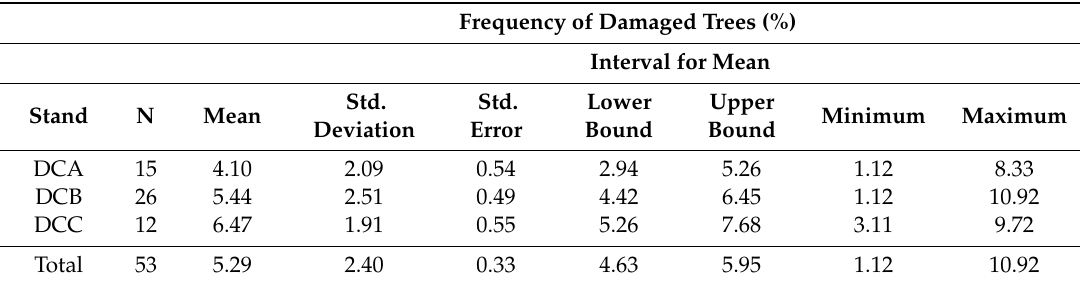
Table 4. Descriptive statistics for the frequency of damaged trees in density classes (DCs). Frequency of Damaged Trees (%) Interval for Mean